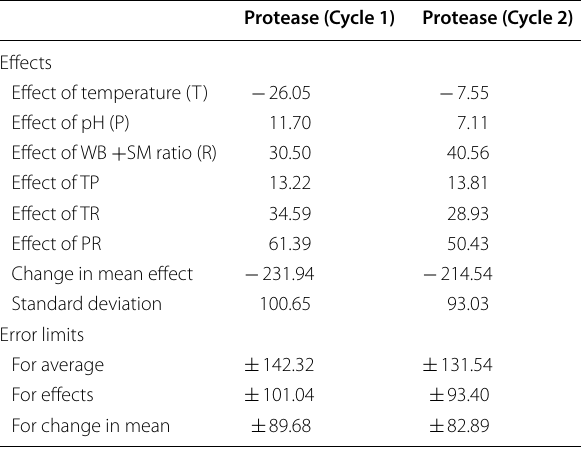
Table 5 Calculations of effects and error limits for cycles I and II for amylase and